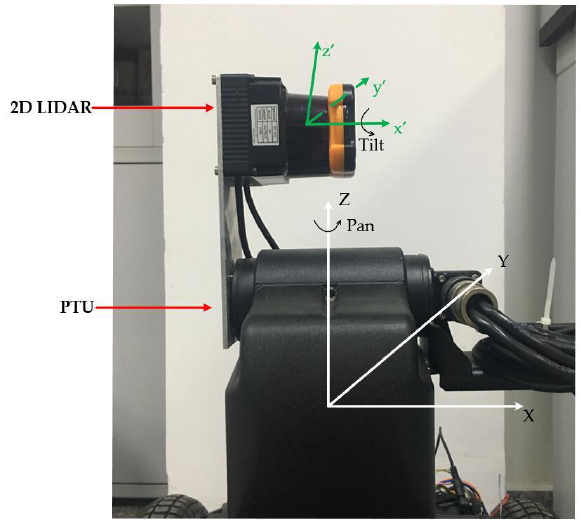
Figure 1. The rotating two-dimensional light detection and ranging (R2D-LIDAR) system composed by a 2D LIDAR and a Pan-Tilt Unit (PTU).